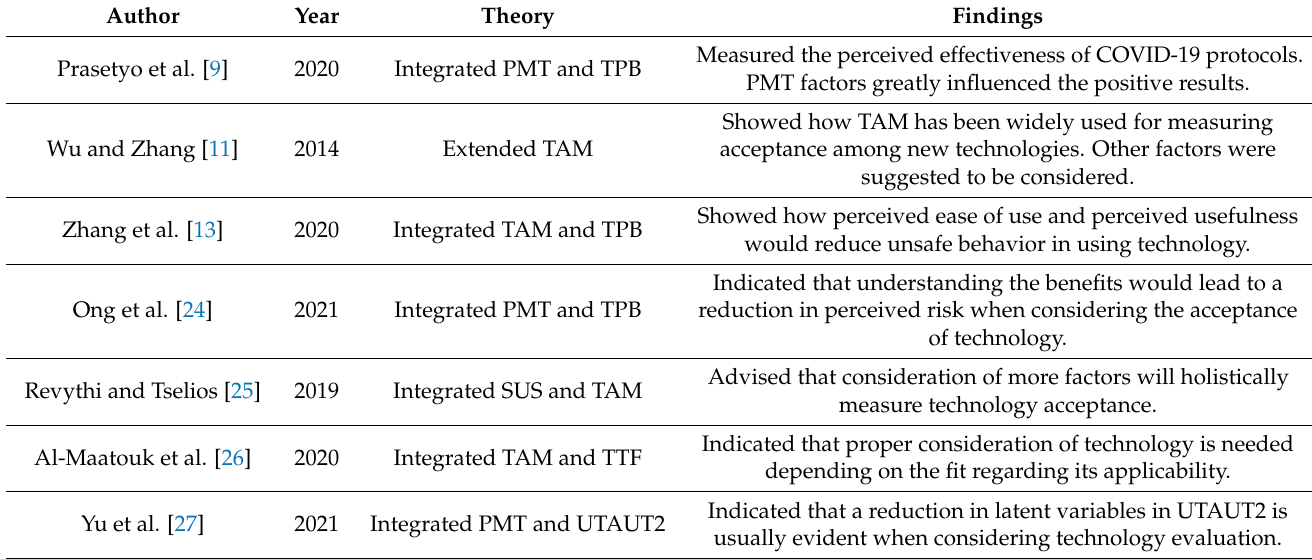
Table 1. Summary of related